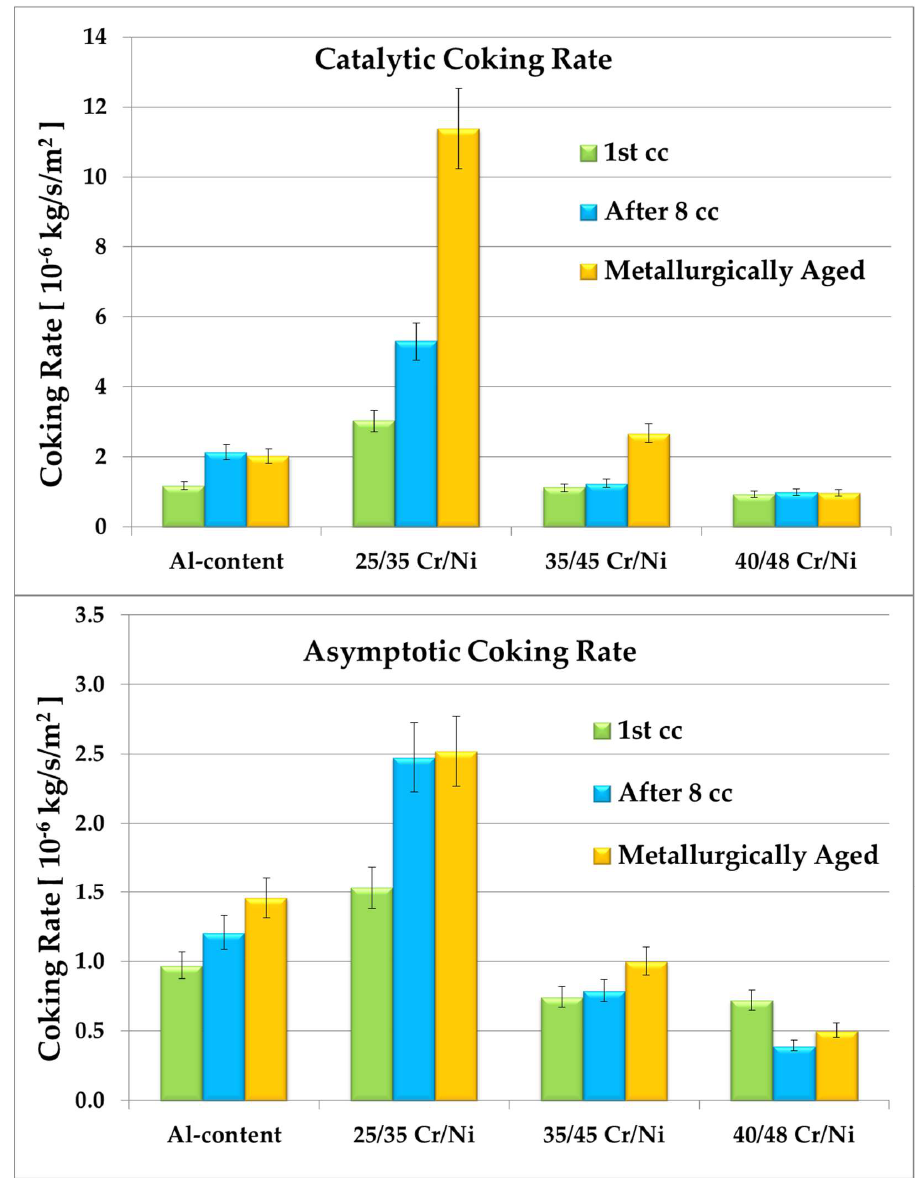
Figure 5. Coking rates for the 1st cracking cycle (green), the one after the cyclic aging (blue) and the one after metallurgic aging